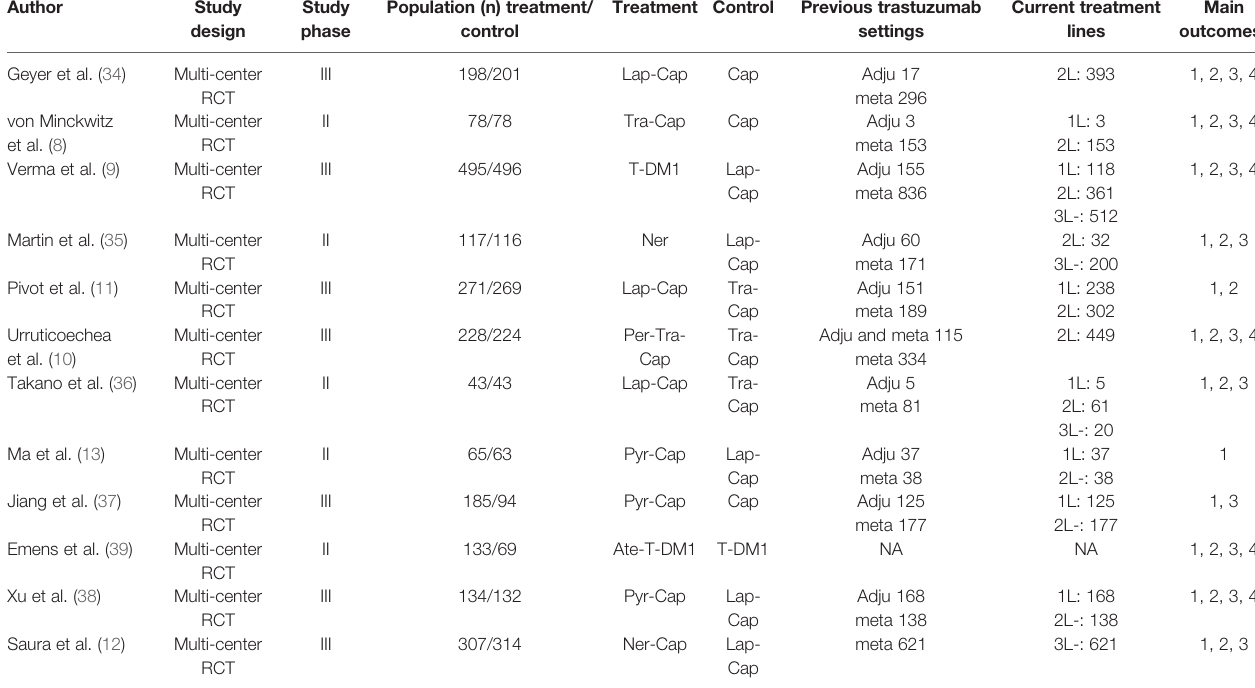
TABLE 1 | Basic characteristics of included studies.